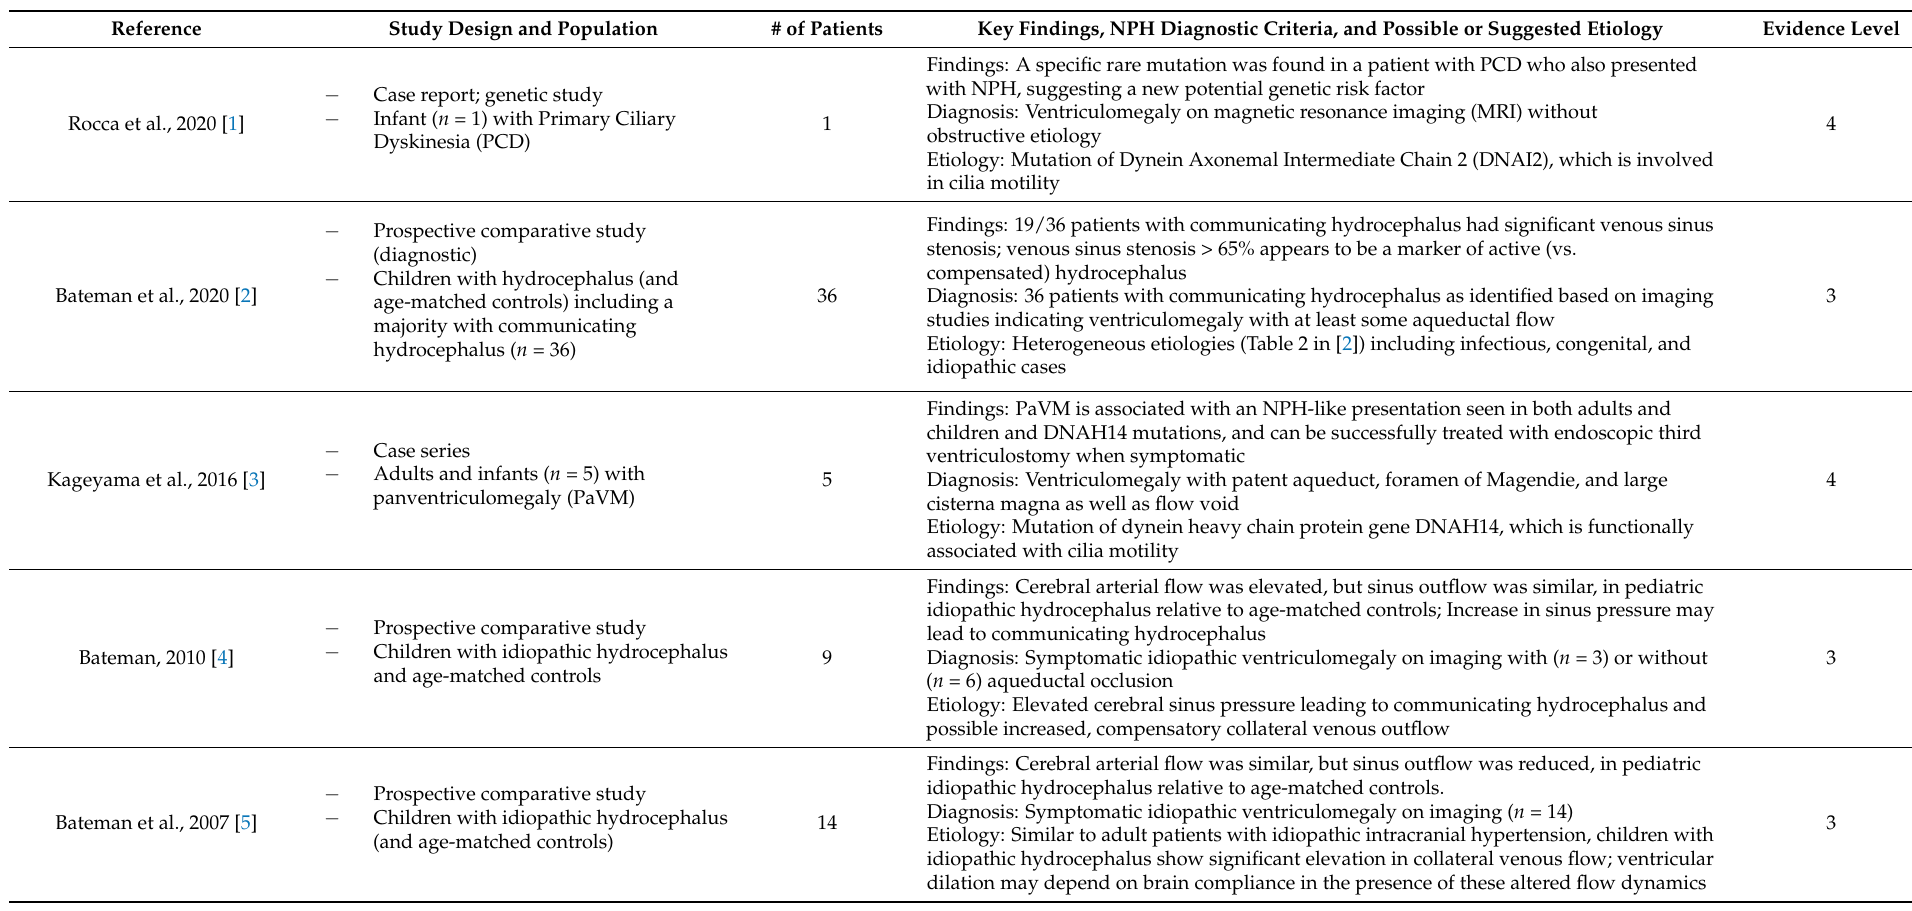
Table 1. Summary of details from the published literature documenting pediatric normal-pressure hydrocephalus (NPH) or NPH-like presentation in children and young adults. References are numbered consistent with the citations